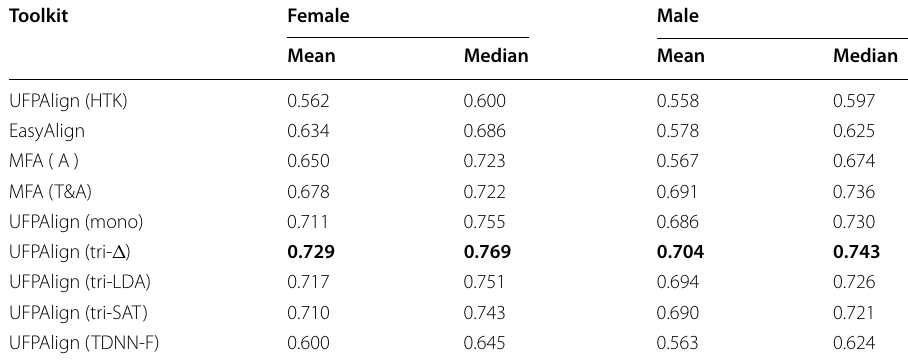
Best results are highlighted in bold